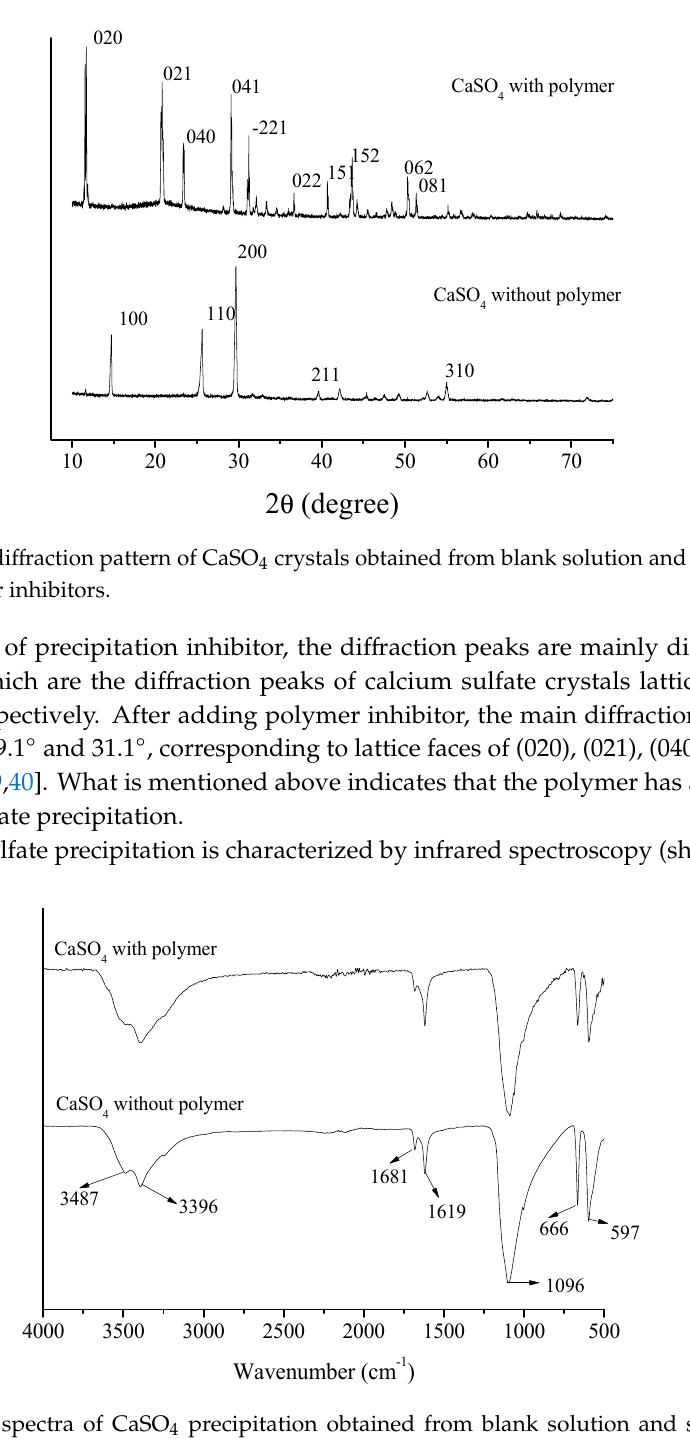
Figure 8. FTIR spectra of CaSO 4 precipitation obtained from blank solution and solutions with polymer inhibitor.